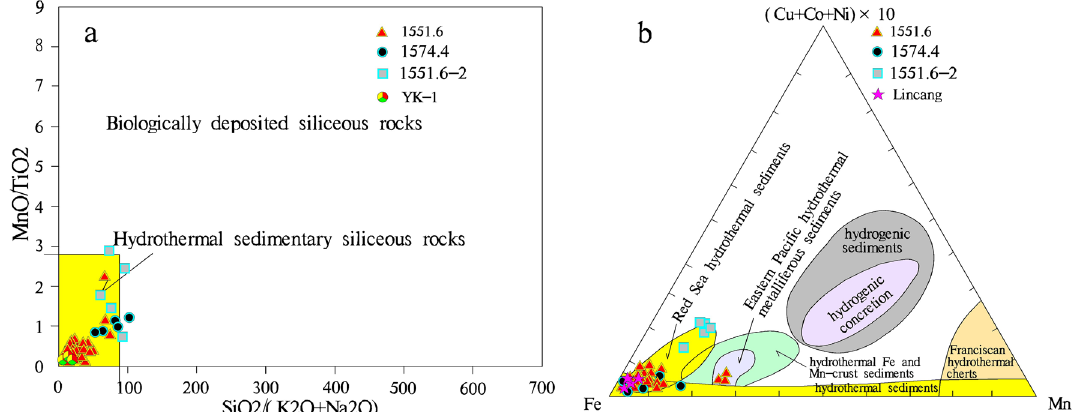
Figure 8. Discrimination diagrams for sedimentary rocks from the Zh22 well in the Ordos Basin (All samples are hydrothermal dolomite). ( a ) SiO 2 /(K 2 O + Na 2 O)-MnO/TiO 215 . The data of 1551.6, 1574.4 and 1551.6–2 are from this study, and the data of YK-1 is from Reference 7 . ( b ) Fe–Mn-(Cu + Co + Ni) × 10 14 . The data of 1551.6, 1574.4 and 1551.6-2 are from this study, and the data of YK-1 is from Reference 16